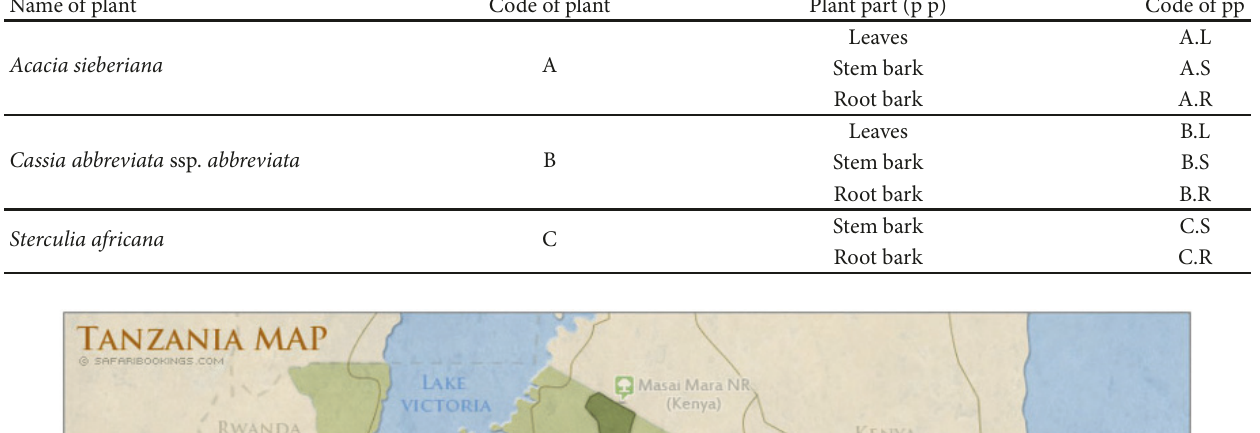
Table 1: Codes of the extracts used during this study.